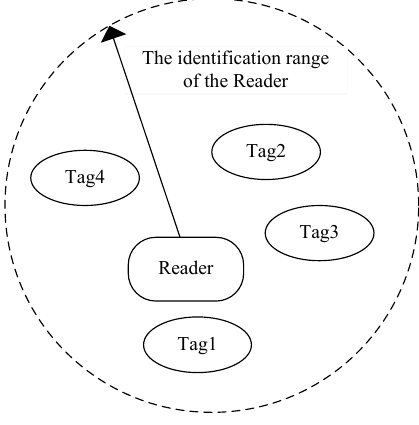
Figure 1. Tag-tag collision diagram.